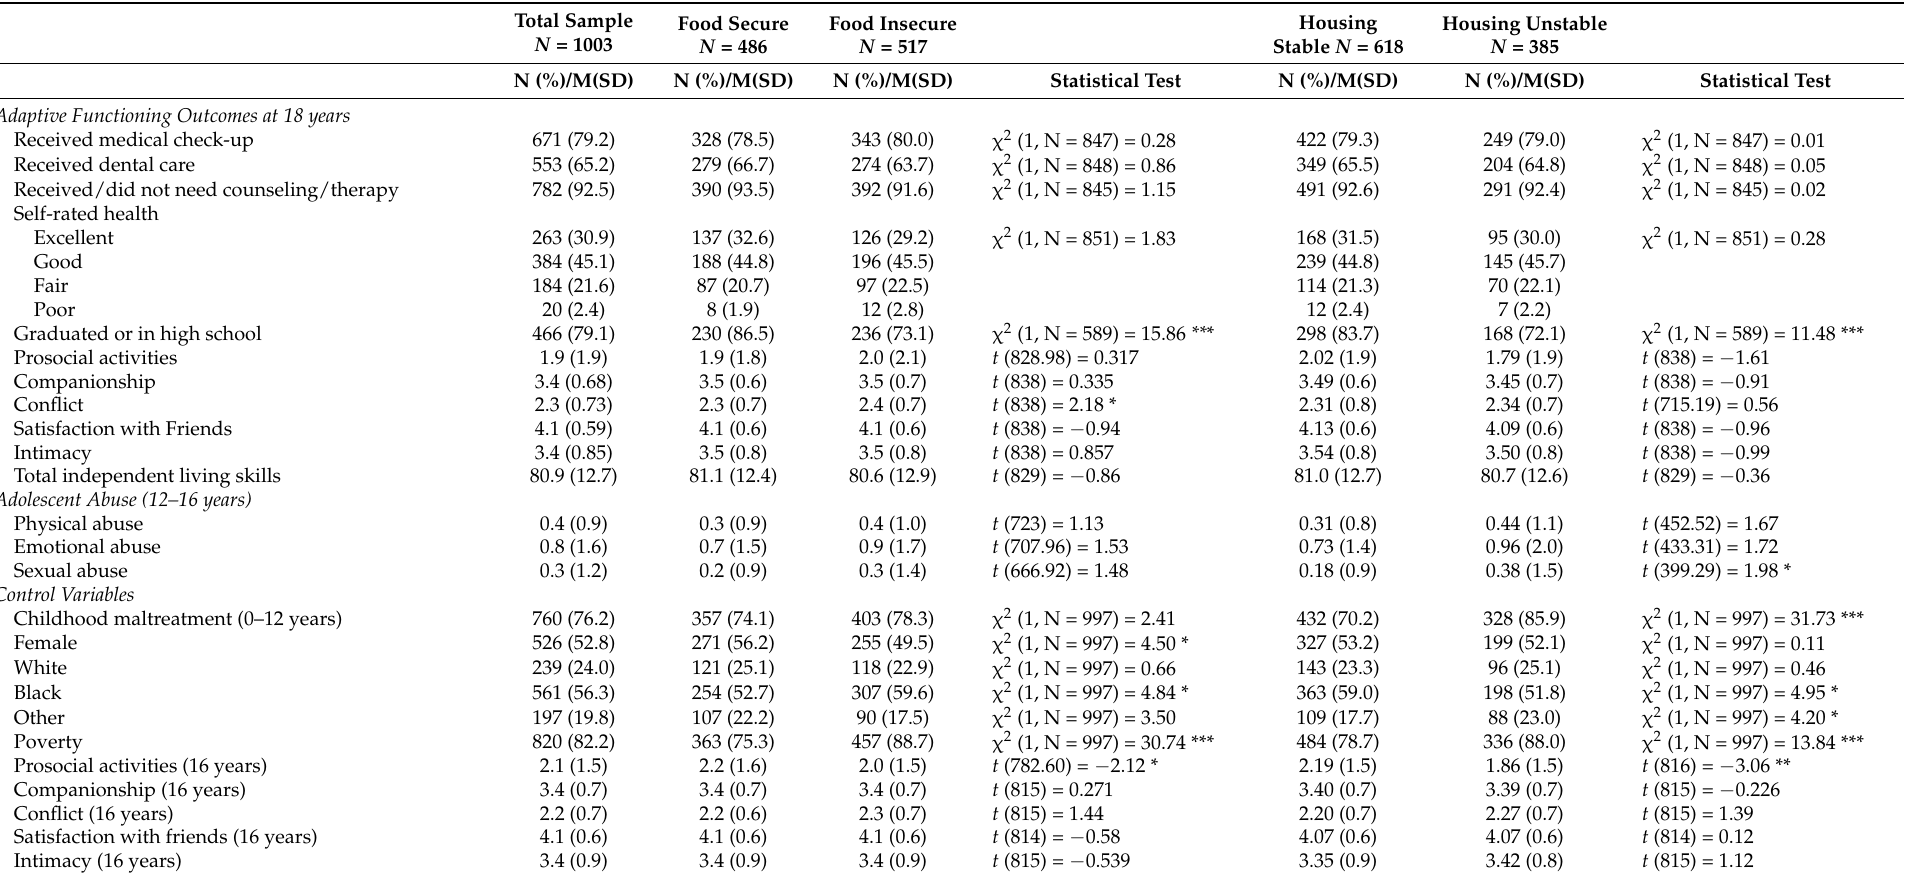
Table 1. Frequencies of Study Variables in Overall Sample, Food Security Groups, and Housing Stability